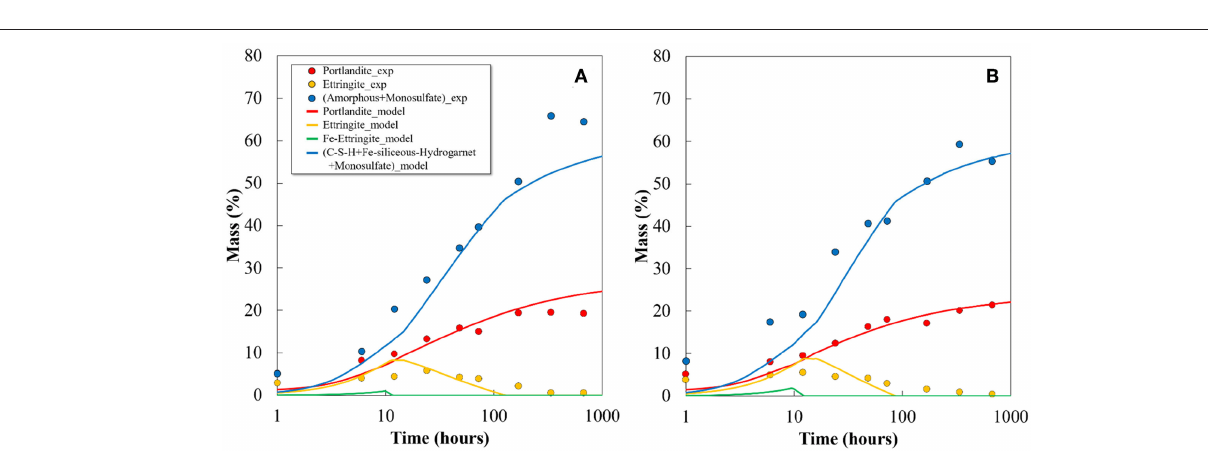
Frontiers in Materials |